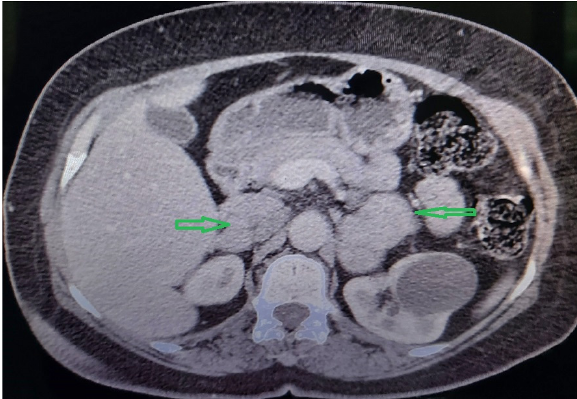
Figure 1: Abdominal computed tomography image showing the bilateral adrenal masses